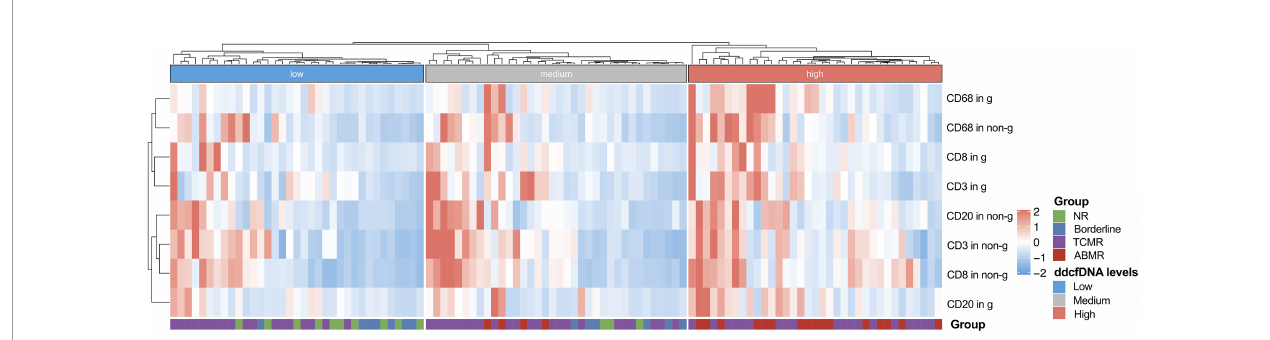
FIGURE 3 | Hierarchical clustering of in fi ltrated in fl ammation in each biopsy with different plasma ddcfDNA levels. Heat map showing T cell (CD3+), cytotoxic T cell (CD8+), B cell (CD20+), and macrophage (CD68+) in fi ltration in glomerular as well as non-glomerular area of low, medium, high levels of plasma ddcfDNA subgroups. Average expression scale is shown on the right.